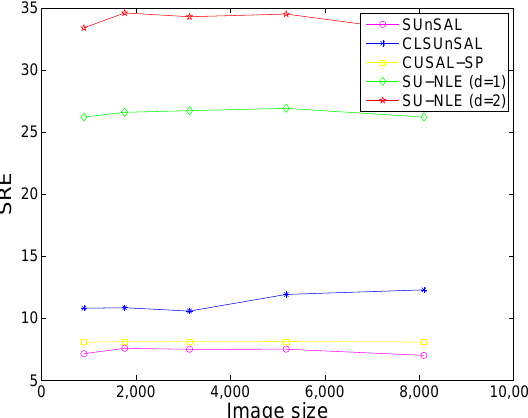
Figure 11. SREs of different methods as a function of varying image size under Gaussian white noise with only mixed regions having 64 × 64 pixels, 4 endmembers and 224